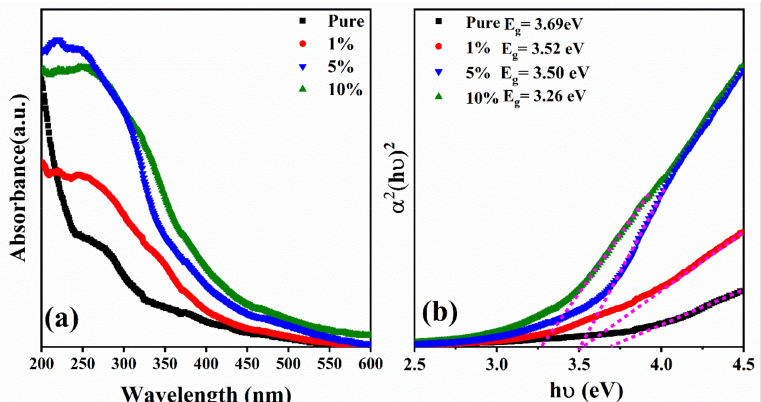
Figure 3. ( a ) Absorption spectra and ( b ) α 2 (h ν ) 2 vs. h ν plots for the band gap (E g ) calculation of POP–BiF 3 (%) composites with the variation of BiF 3 concentration 0%, 1%, 5%, and 10% in POP